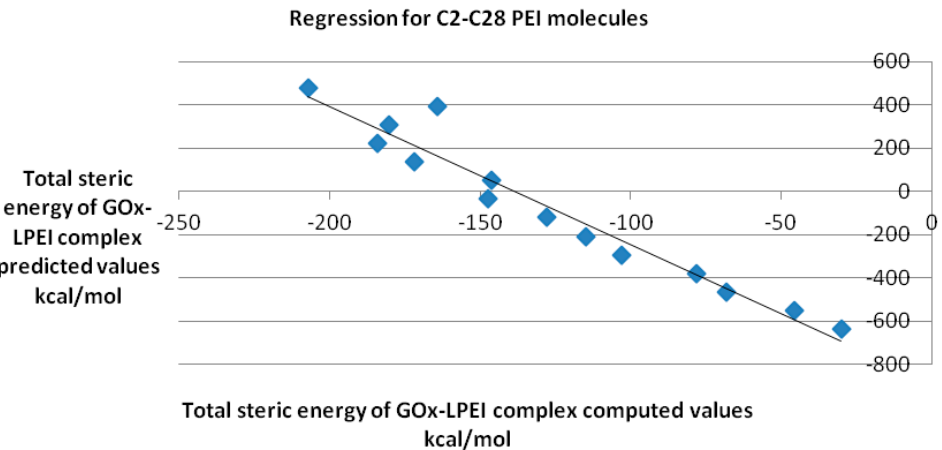
Figure 10. QSAR model for GOx-LPEI complex (data computed by docking).